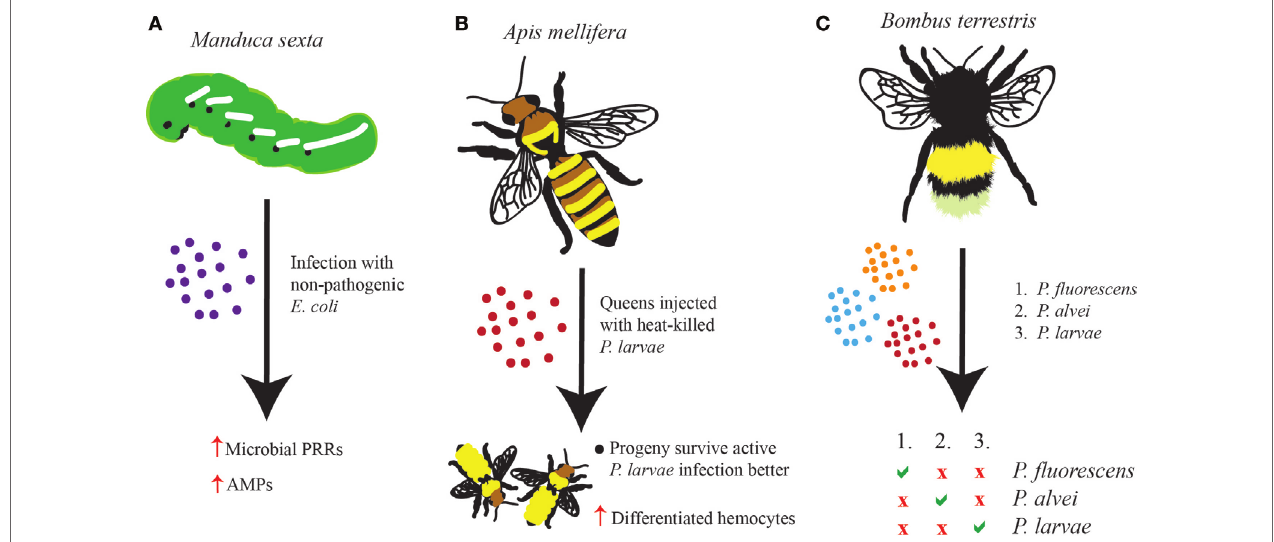
FiGURe 1 | evidence of immune priming in insects has emerged in many different forms and to varying extents . (A) Infection of Manduca sexta larvae with non-pathogenic Escherichia coli leads to the upregulation of microbial pattern-recognition receptors and antimicrobial peptides such that the insect survives better against a secondary infection with a pathogenic microbe, such as Photorhabdus luminescens . (B) Queen Apis mellifera honeybees injected with heat-killed Paenibacillus larvae give rise to progeny, which contain as much as three times as many differentiated hemocytes and which survive better against P. larvae infection than honeybees whose parents had not been injected. (C) The Bombus terrestris immune response exhibits a great deal of memory and specificity after being primed with one of three pathogens ( Pseudomonas fluorescens , Paenibacillus alvei , or P. larvae ). Survival against a homologous secondary infection is increased; however, no change in survival is seen against heterologous secondary